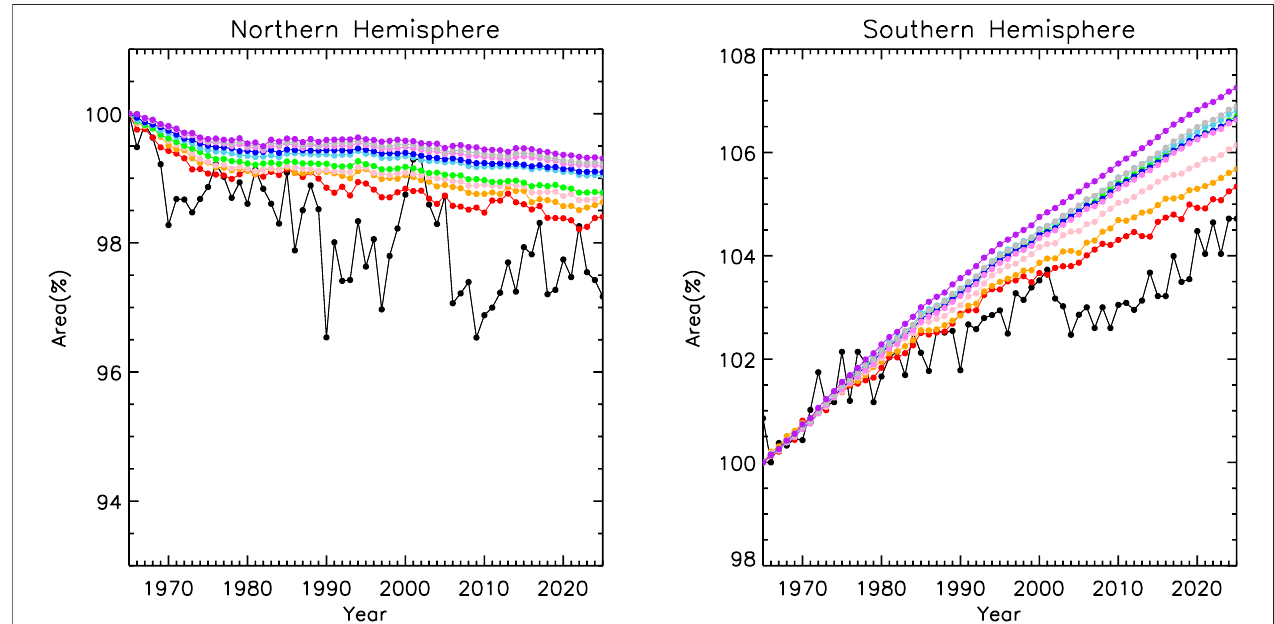
FIGURE11| ChangesoftheEPWs ’ areawithtimeunderdifferentbackgroundmagnetic fi eldsforboththenorthandsouthhemispheres.Thecolors “ black, ”“ red, ” “ orange, ” “ pink, ” “ green, ” “ sky blue, ” “ blue, ” “ violet, ” “ gray, ” and “ purple ” represent 0.1, 1, 2, 3, 4, 5, 6, 7, 8, and 9 GV, respectively.